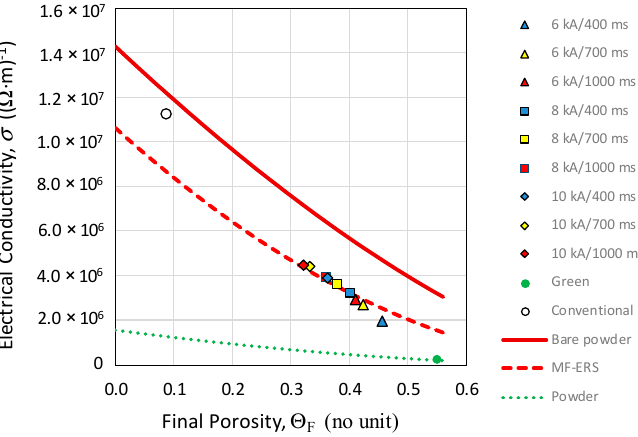
Figure 13. Electrical conductivity vs. final porosity in the MF-ERS compacts, conventional compact and green compact. The theoretical models given by Equation (4) with different values are also represented.